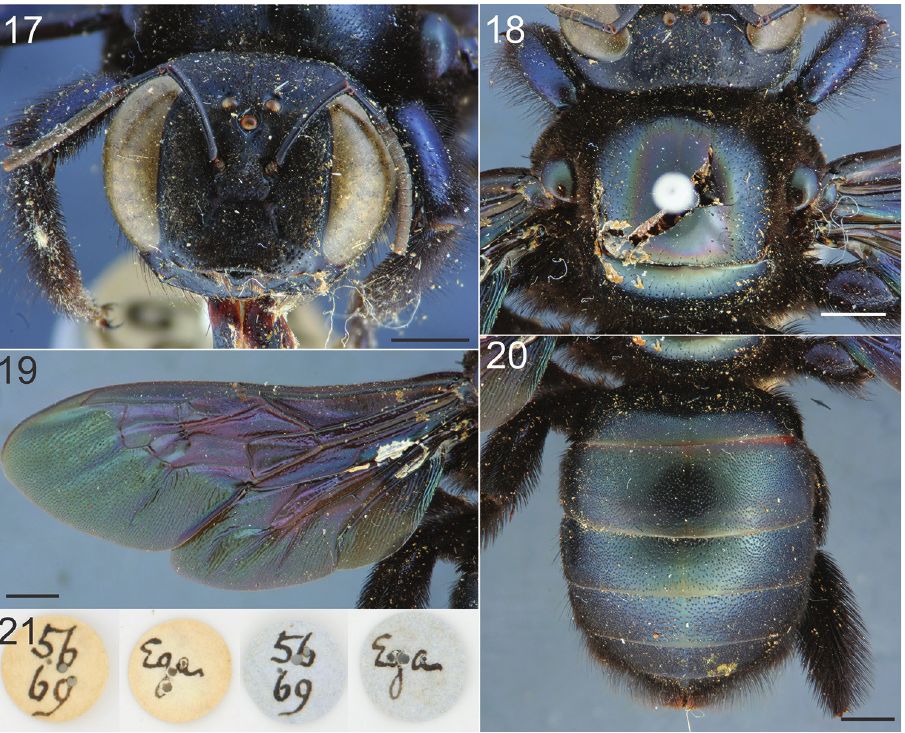
Figures 17–21. Neotype of X. dimidiata Latreille. 17 Facial view 18 Dorsal view of head and mesosoma 19 Left fore and hind wings 20 Detail of metasomal terga 21 Associated labels